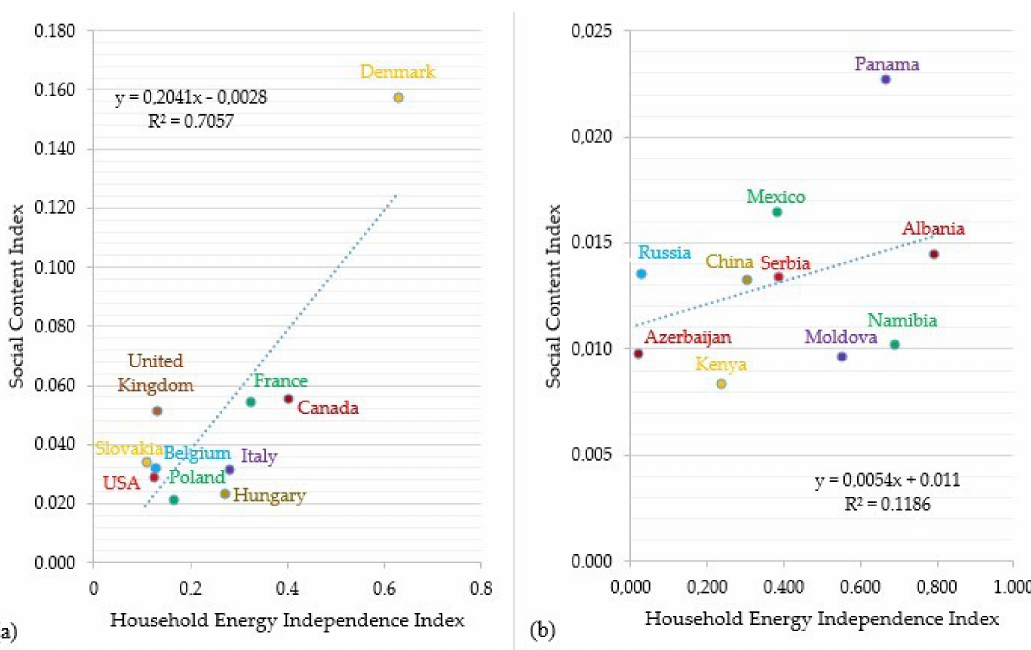
Figure 4. Relationship between Social Content Index of countries and the index of energy independence of households of the studied developed ( a ) and developing ( b ) countries. Source: generated by the